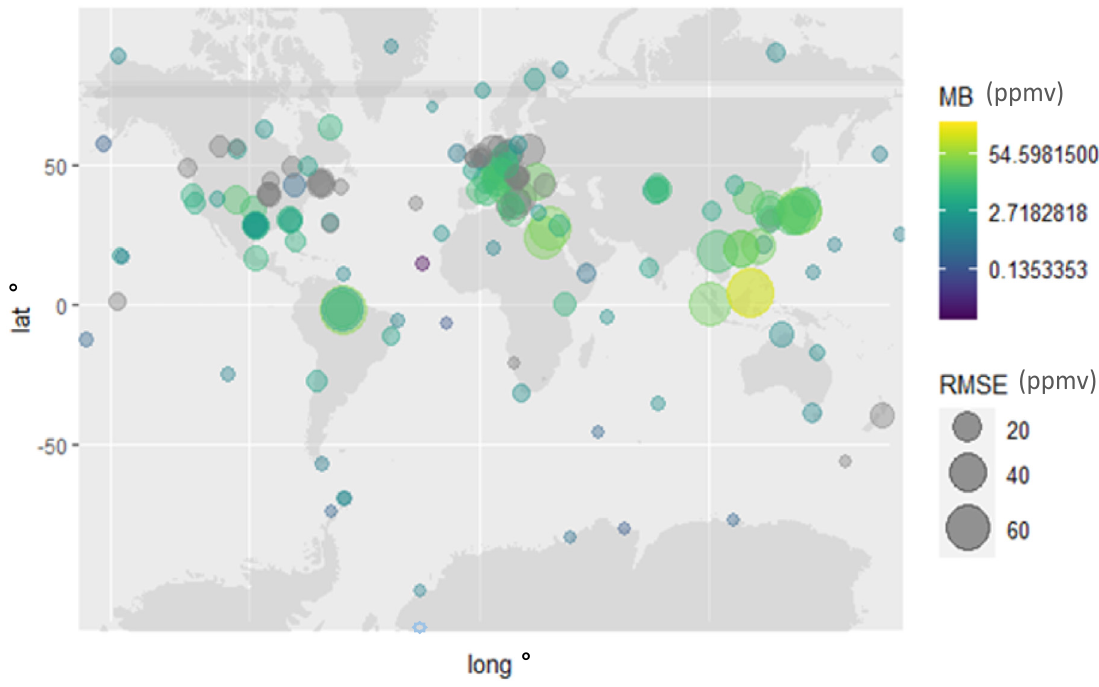
Figure 2. Mean bias (MB) and RMSE (in ppmv) displayed by CO 2 re-analysis product provided by CAMS-EAC4 in the comparison with worldwide in situ observation considered in this study. The compliance metric for each station can be accessed through the hypergraph available at (https: